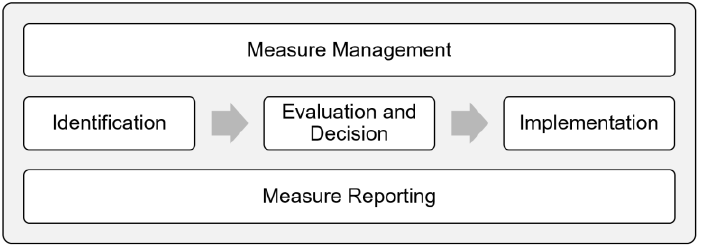
Figure 5. Approach to early product-cost optimization